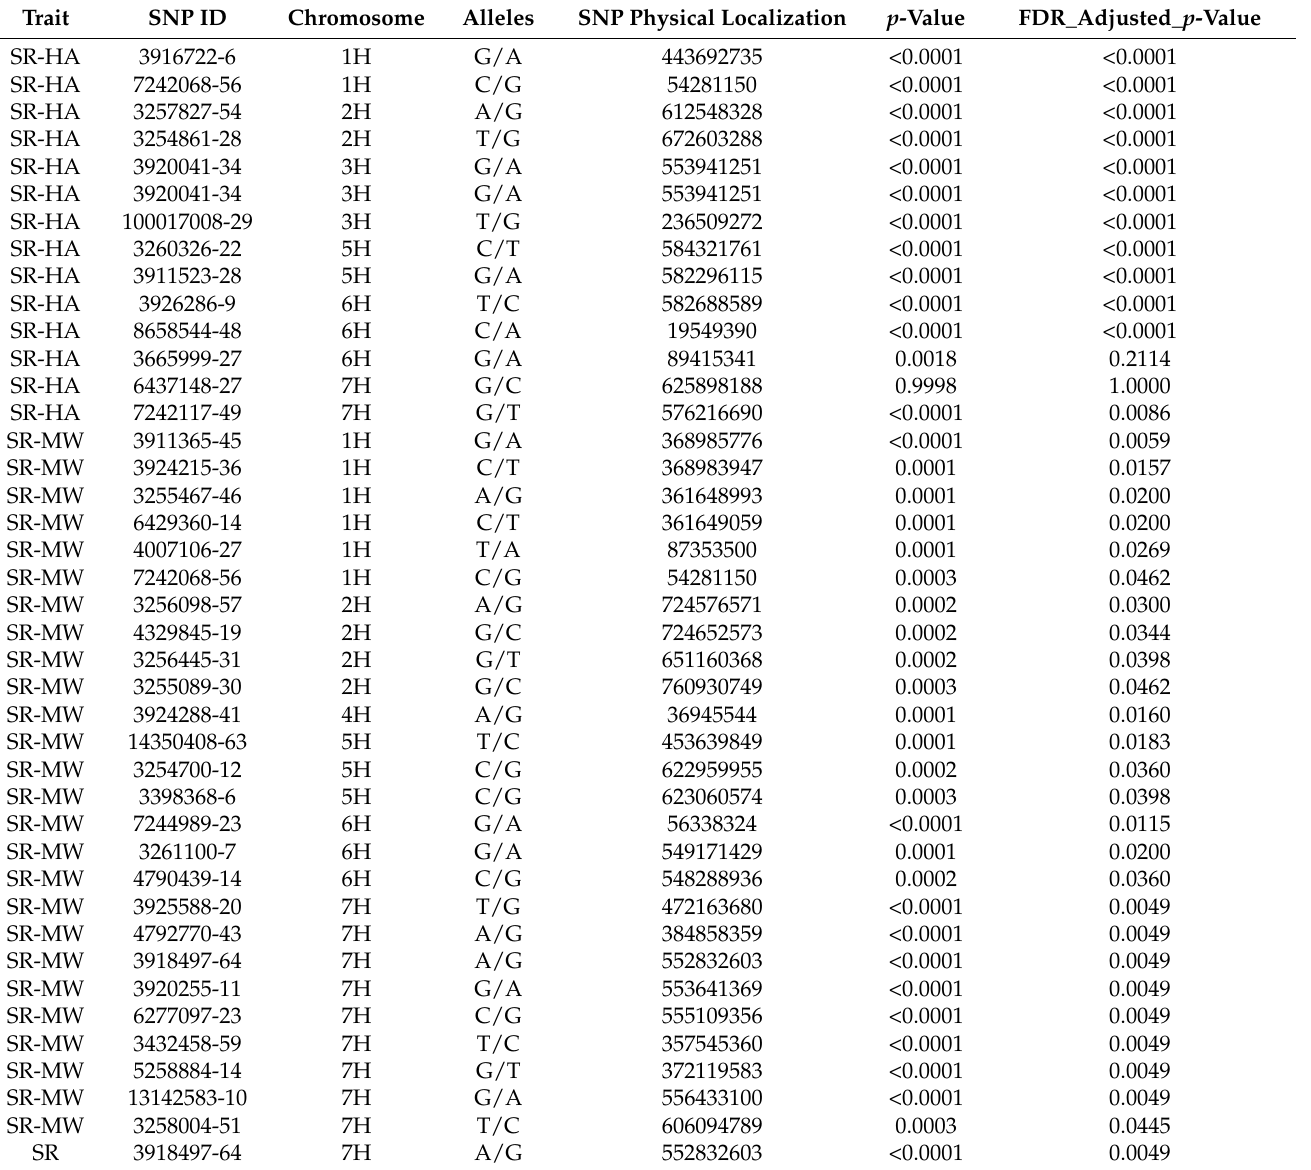
Table 6. Significant marker–trait associations (MTAs) for resistance to stem rust (SR) at heading, (HA) milky-wax (MW) seed stage and maximum disease scored across all replicates